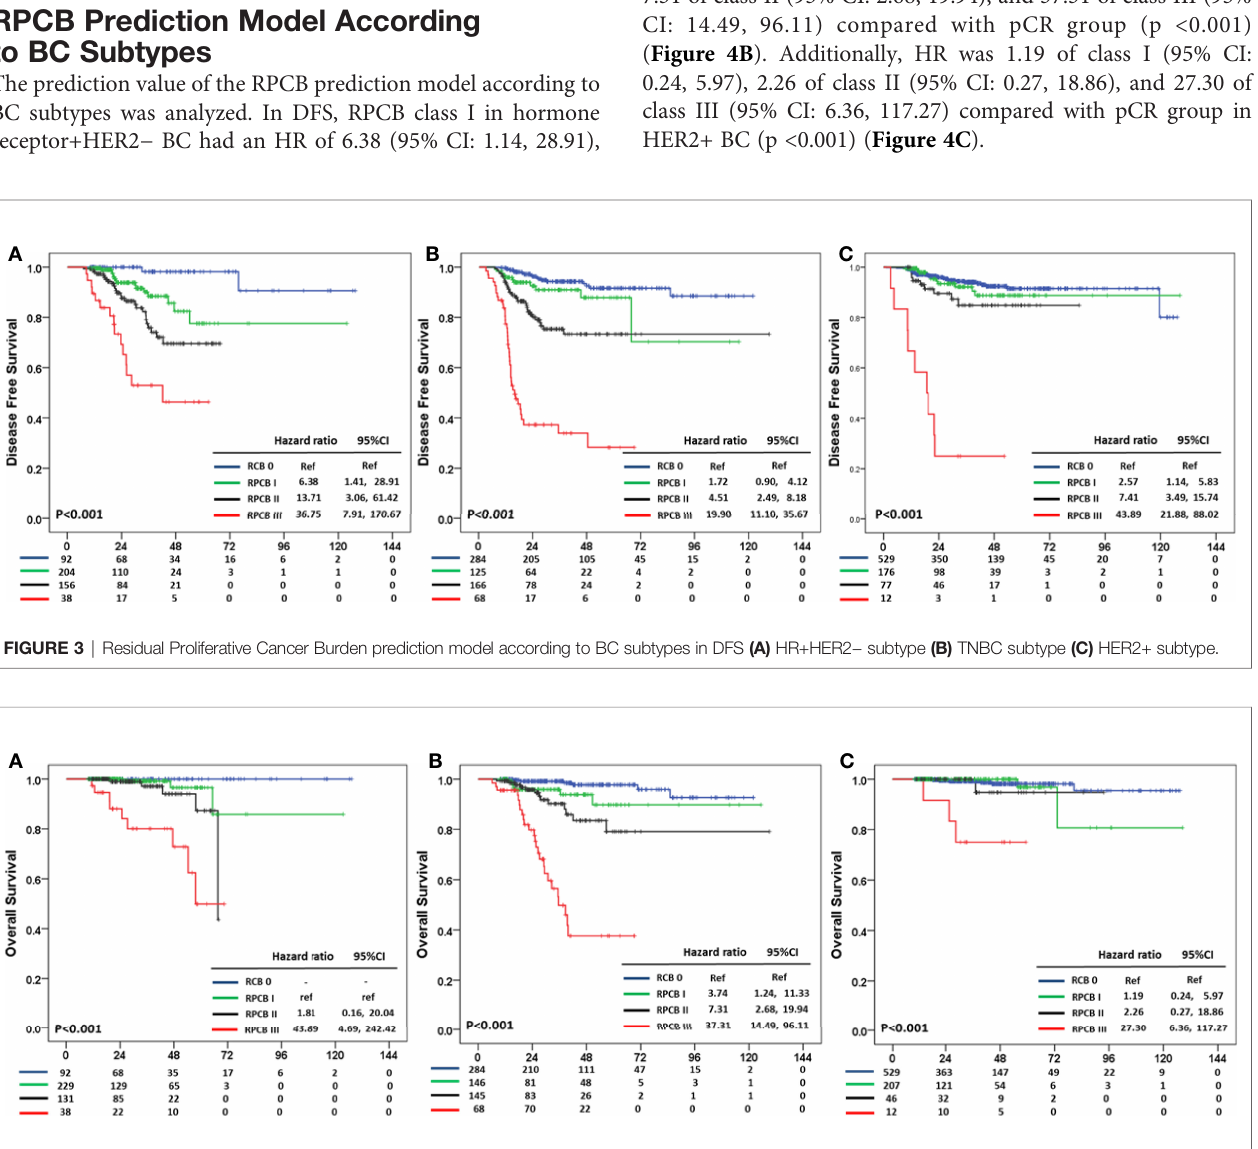
FIGURE 4 | Residual Proliferative Cancer Burden prediction model according to BC subtypes in OS. (A) HR+HER2 − subtype. (B) TNBC subtype. (C) HER2+